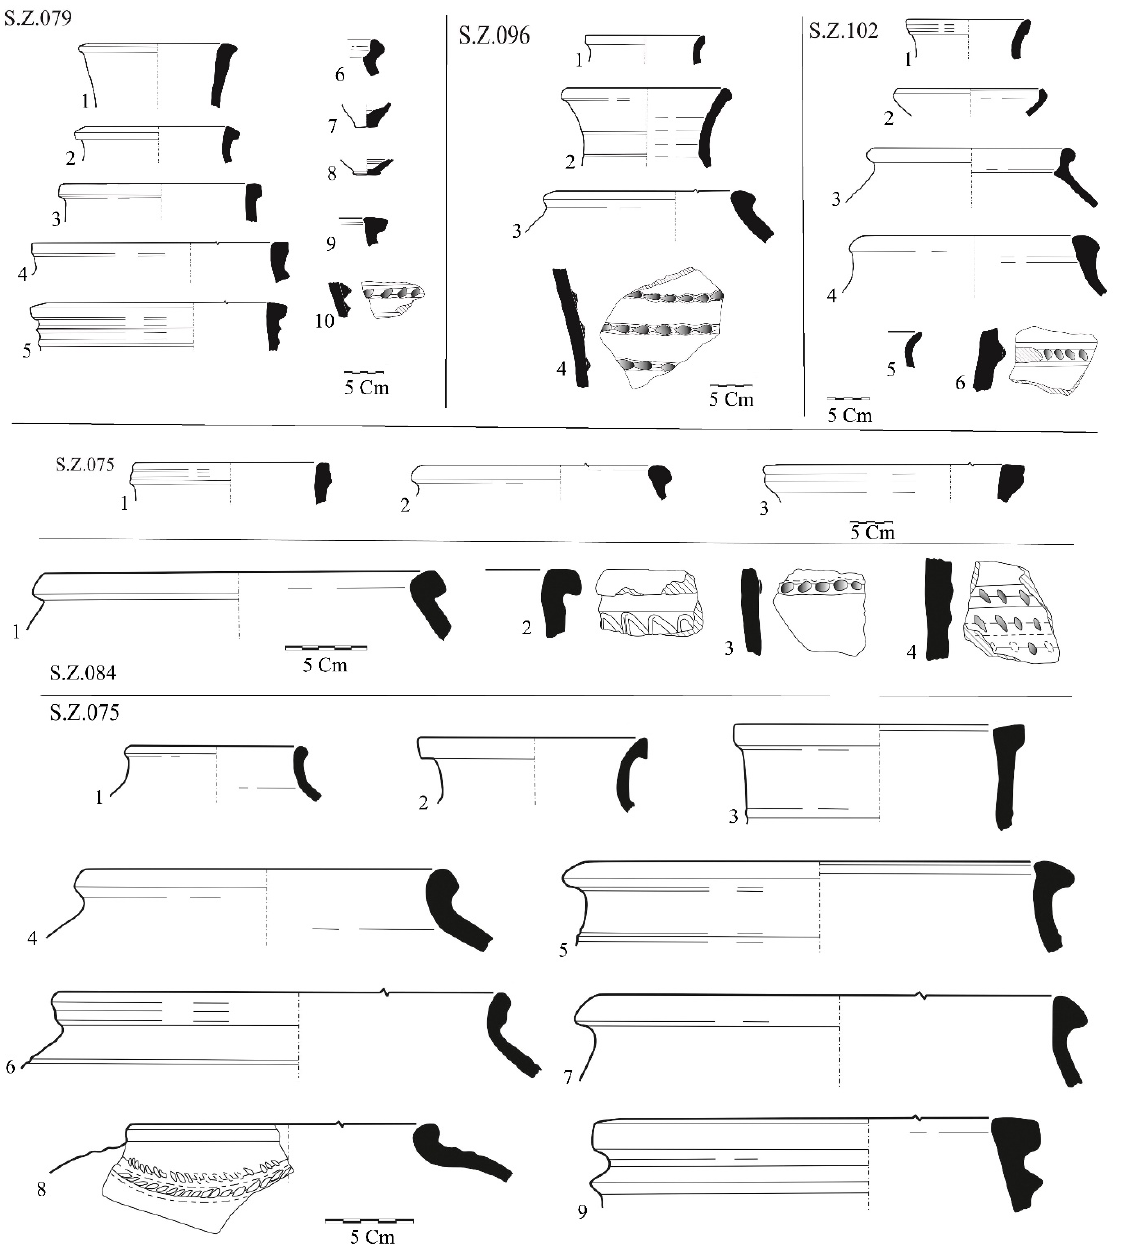
Figure 3 Selected potsherds from the seasonal sites of the Sar Pol-e Zahab with rock mortars (drawing by Somayeh